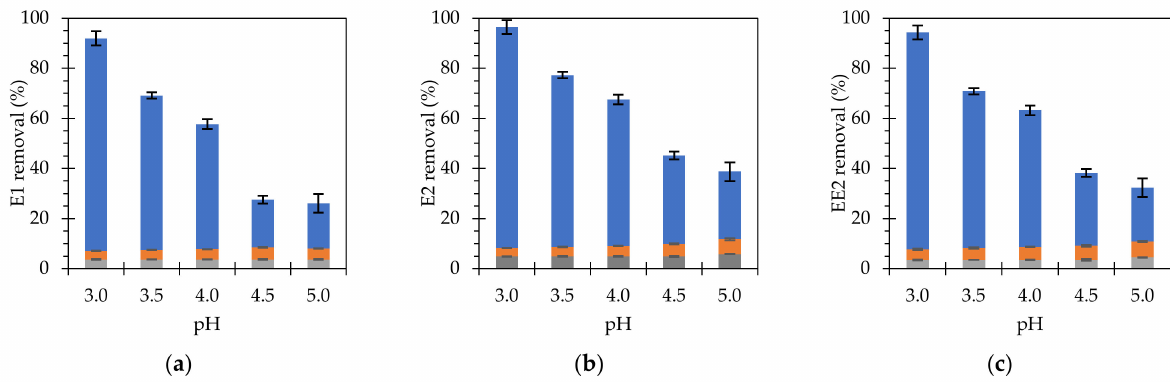
Figure 6. Effect of pH on the removal of ( a ) E1, ( b ) E2 and ( c ) EE2 (initial concentration of 350 µ g L − 1 ), using [Fe] at 750 mg L − 1 and H 2 O 2 at 300 mg L − 1 after 6 h. Blue bars represent estrogen removal by Fenton reactions; grey bars represent estrogen removal by adsorption; orange bars represent H 2 O 2